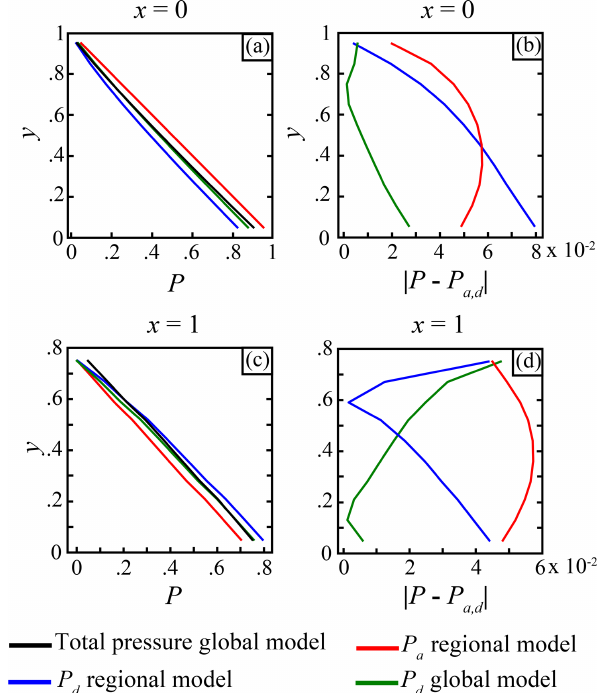
Figure 6. Curves showing the pressure from the regional and global models along the profiles (a) x = 0 and (c) x = 1. Absolute value of the difference between the total pressure P in the global model and the different pressures in the global and regional models along the profiles (b) x = 0 and (d) x = 1.